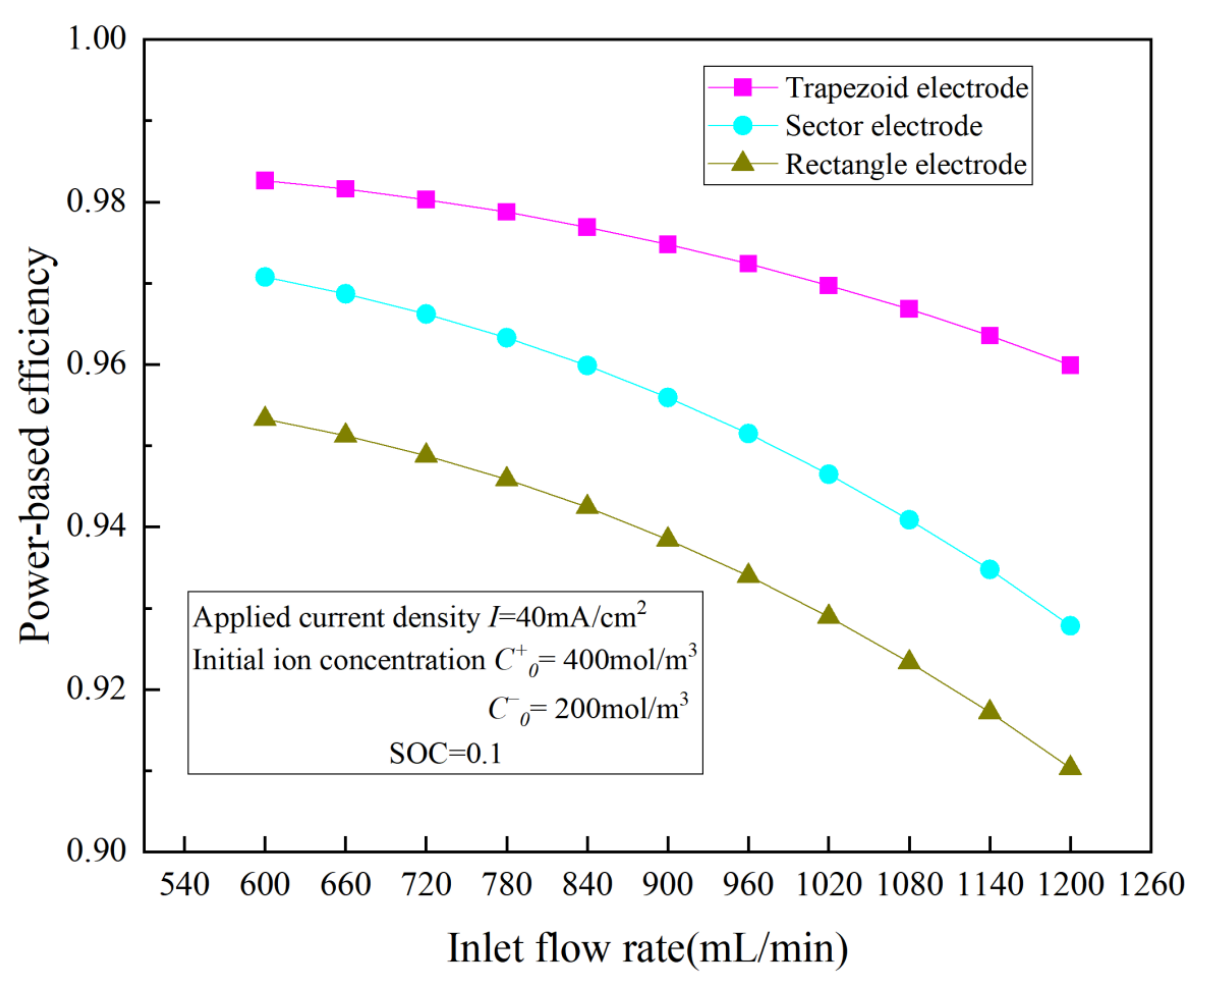
Figure 14. Variations in power efficiency with inlet concentration.